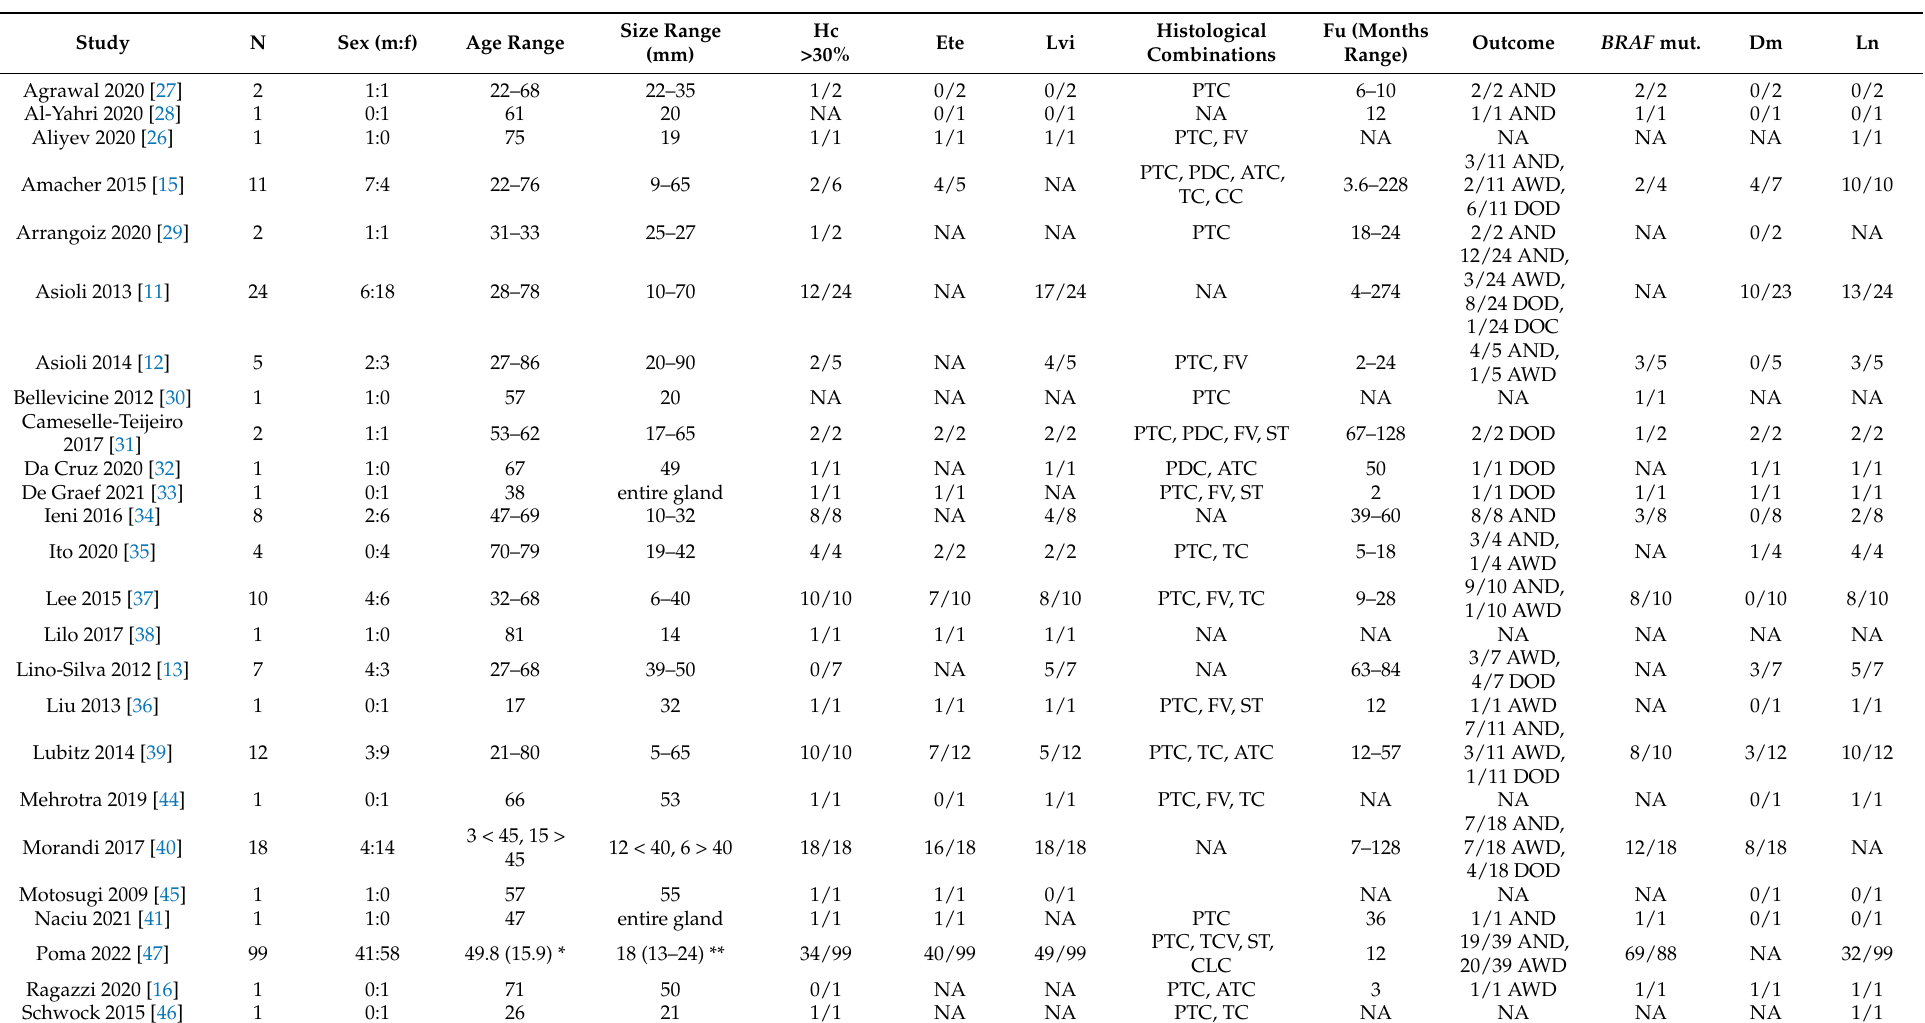
Table 1. Demographic and clinicopathological characteristics of included